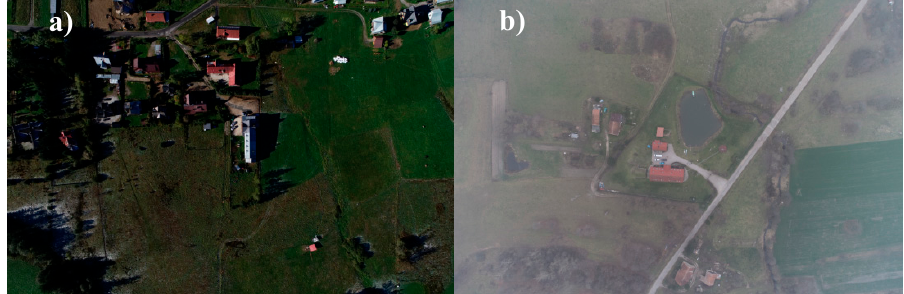
Figure 15. Sample photos obtained ( a ) September 26, 2018, in Ko´scielisko, and ( b ) November 22, 2018, in Mieruniszki.